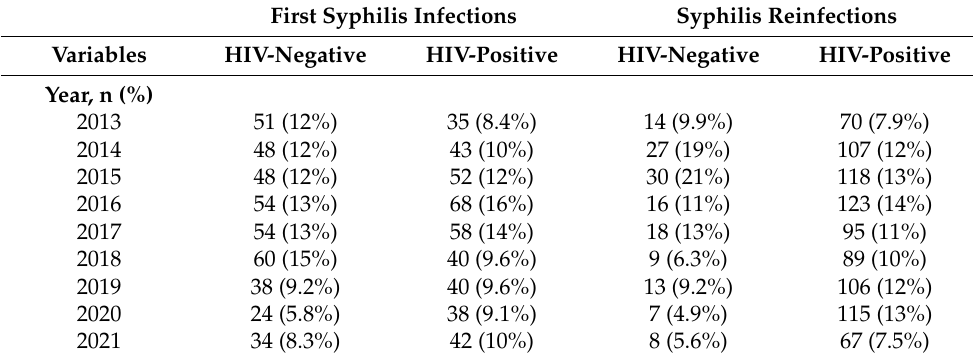
Table 1. Number of first syphilis infections and reinfections per year during the study period. First Syphilis Infections Syphilis